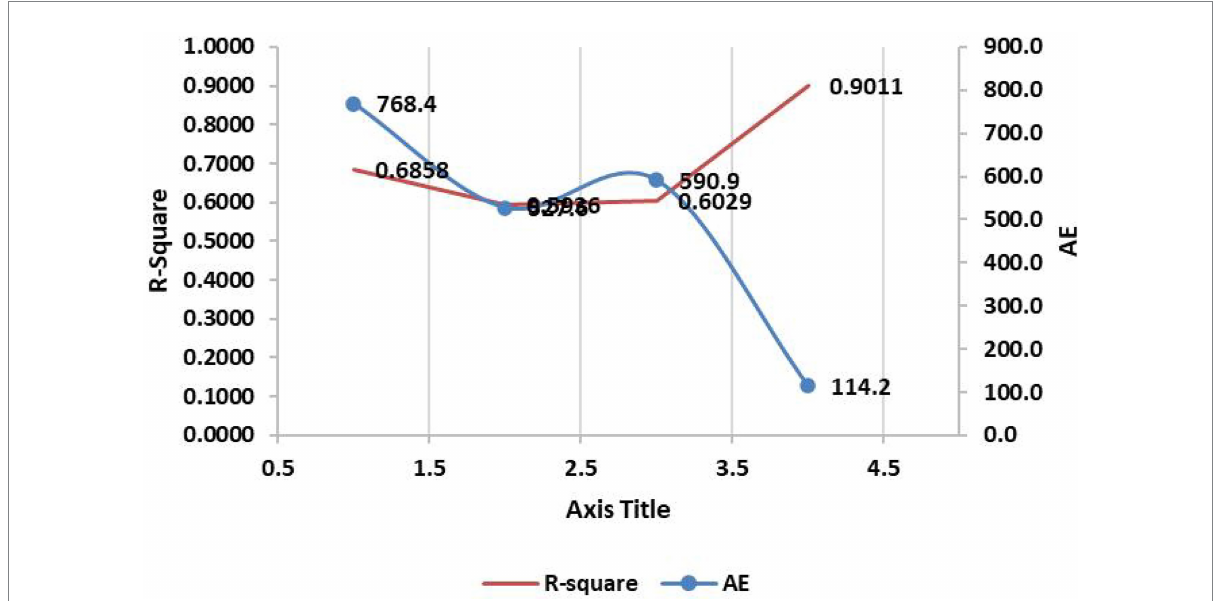
FIGURE 6 Comparison of for k prediction based on RBFNN-GA algorithm and empirical